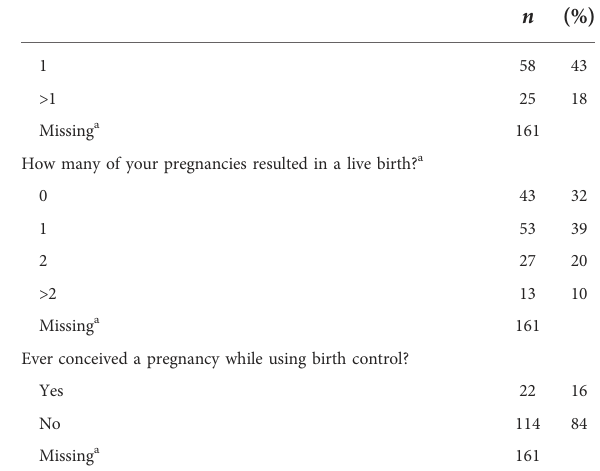
TABLE 2 Behavioral and reproductive characteristics of participants who were trying to conceive ( n